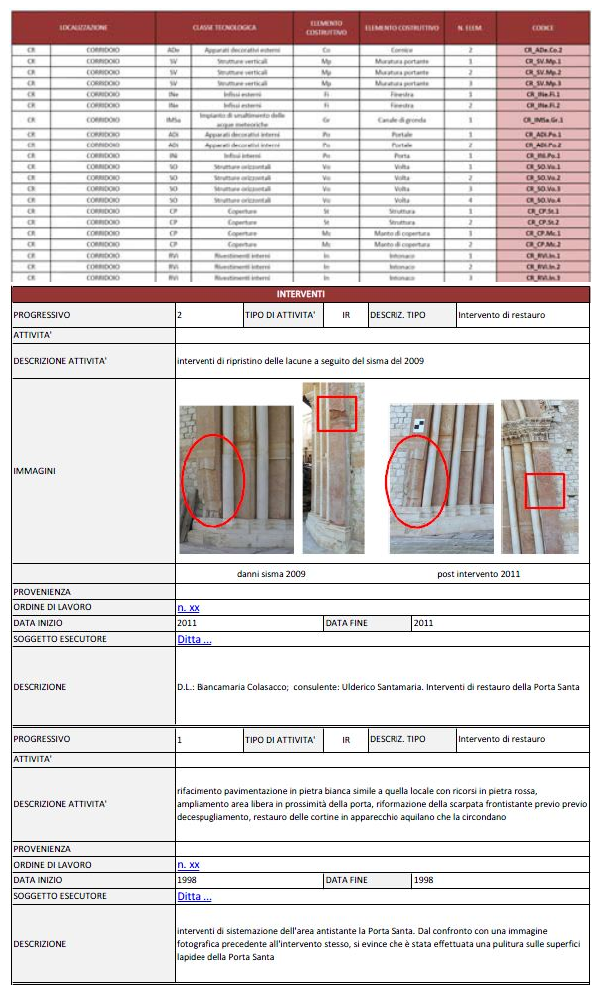
Figure 4. Codification of constructive elements in the Conservation Plan (above) and an example of Plan table (below).